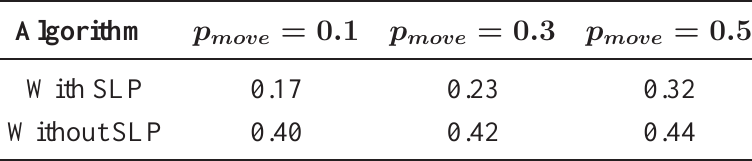
Table 3. Performance of SLP: deadline miss